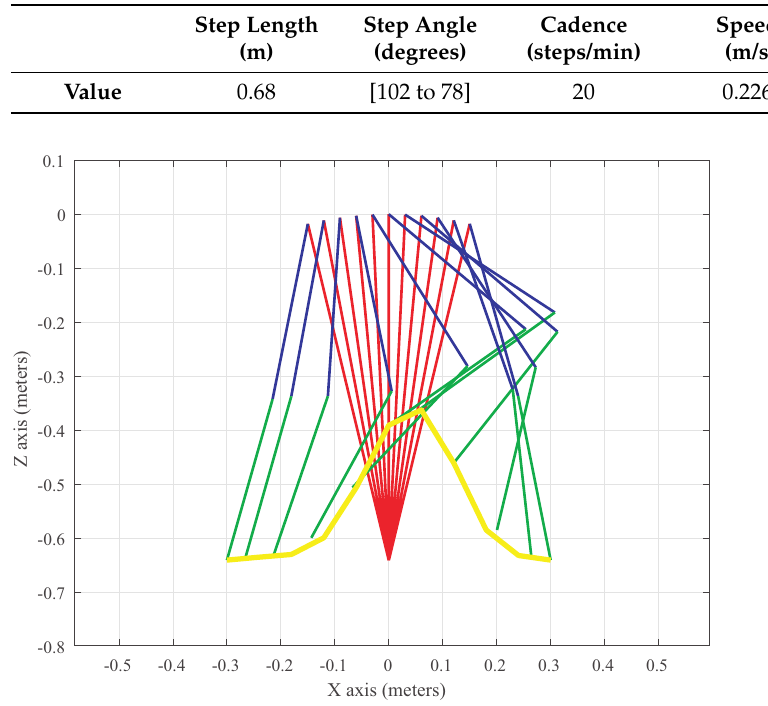
Figure 7. Evolution of the leg trajectory in the sagittal